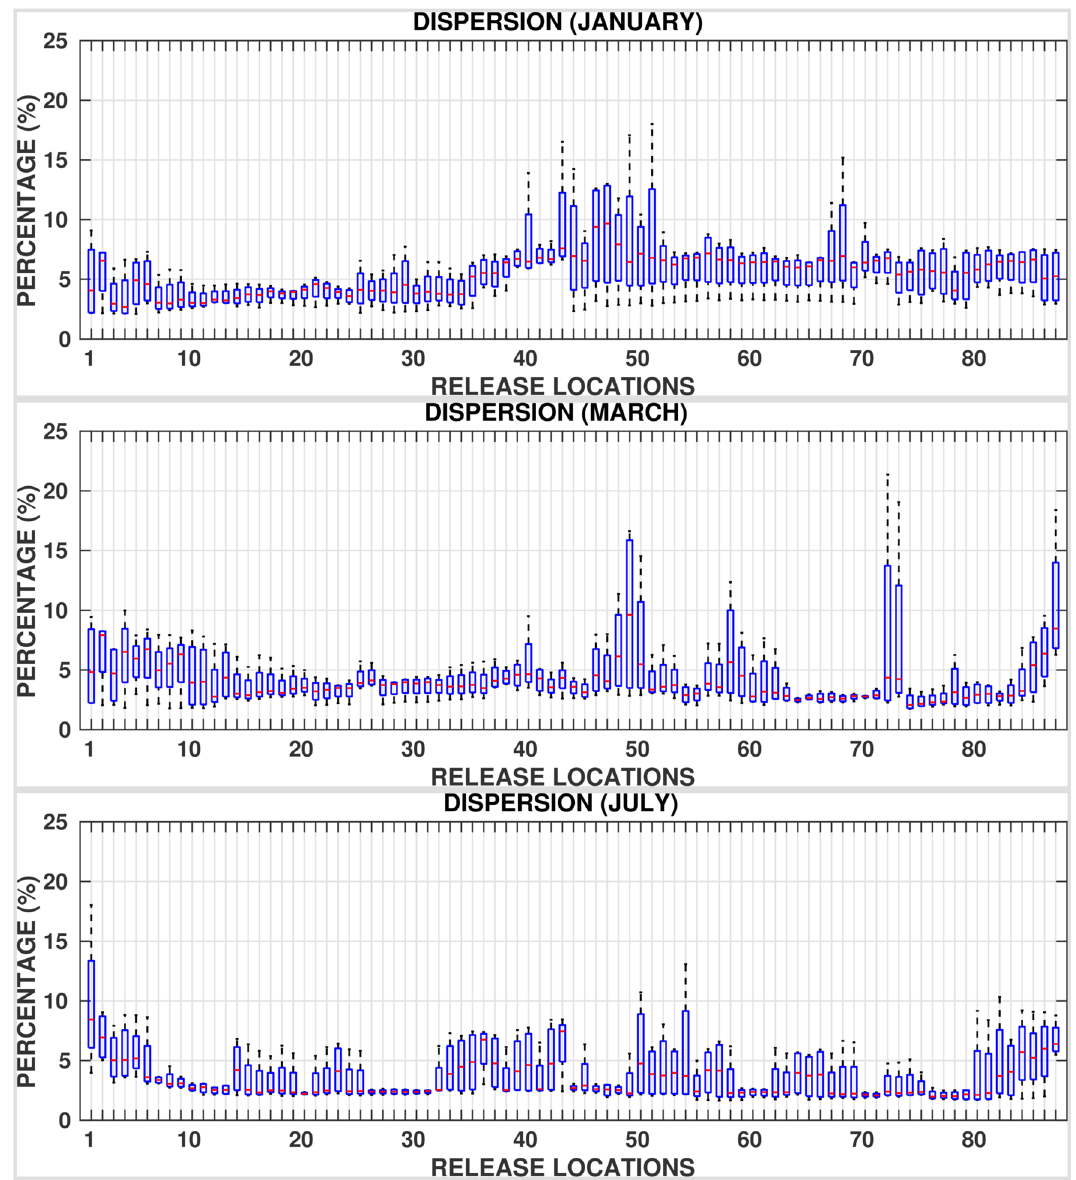
Figure 10. Percentages of oil dispersed, twenty (20) days after the commencement of the spill for each release location ( RL i : i = 1 : 87 ) for all the 4 years considered in